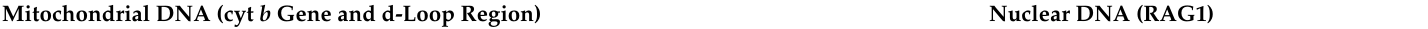
Table 1. Sampling localities, abbreviations, and genetic diversity indexes for O. hainanensis based on mitochondrial and nuclear data. N, sample size; Nh, haplotype numbers; h , haplotype diversity; π , θ , nucleotide diversity. Values in bold indicated geographic